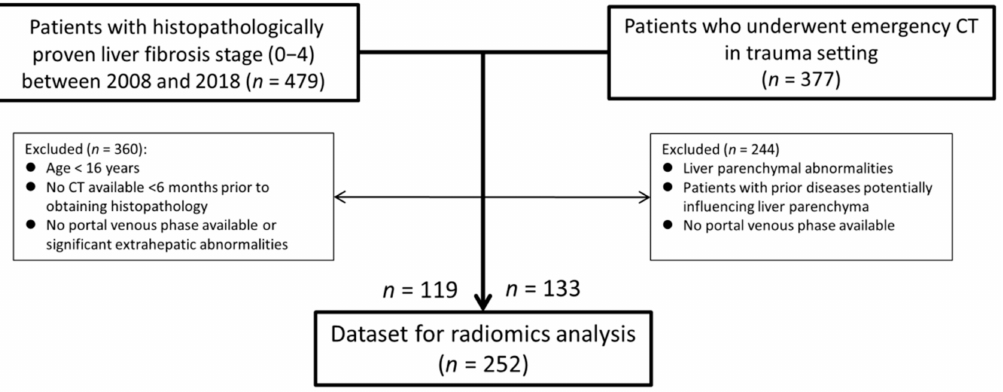
Figure 1. Flowchart of the study population. Abbreviation: CT = computed